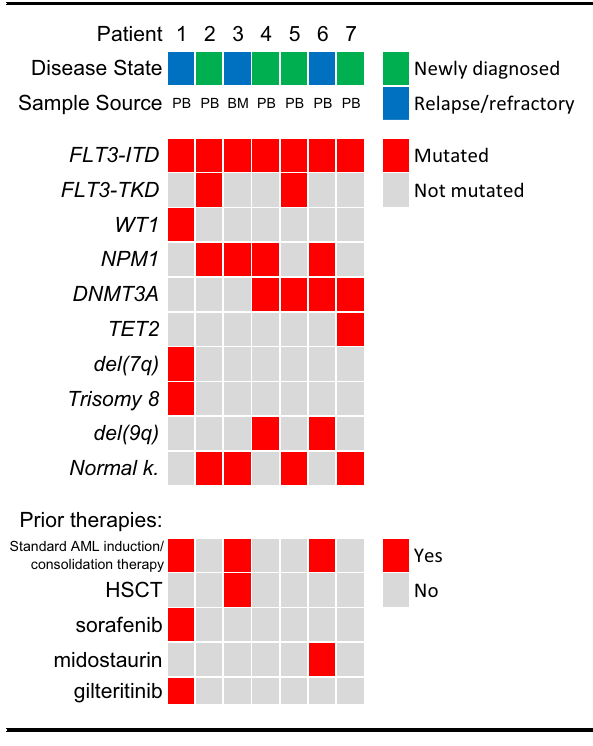
Table 1 Patient information for primary cell